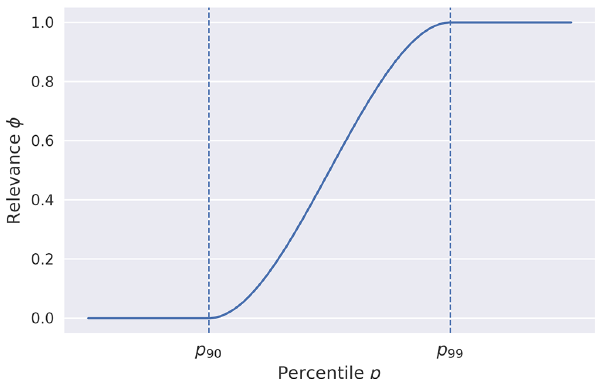
Figure 5. The relevance function φ obtained by interpolating the control point of minimum relevance and the control point of maximum relevance, chosen as the 90th percentile ( p 90 ) and the 99th percentile ( p 99 ) in this figure, using the pchip interpolation